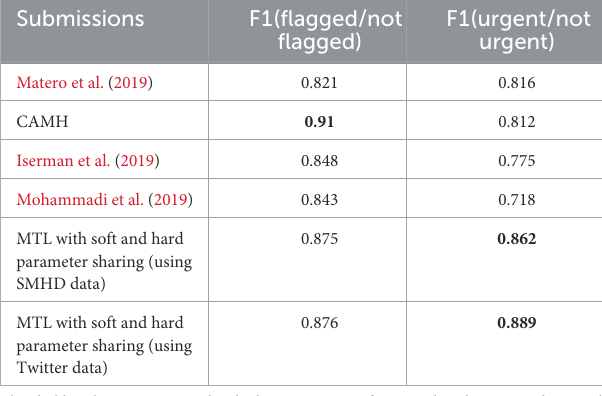
TABLE 9 Related work comparison for suicide ideation detection (using SMHD and CLPsych 2015 Twitter data).